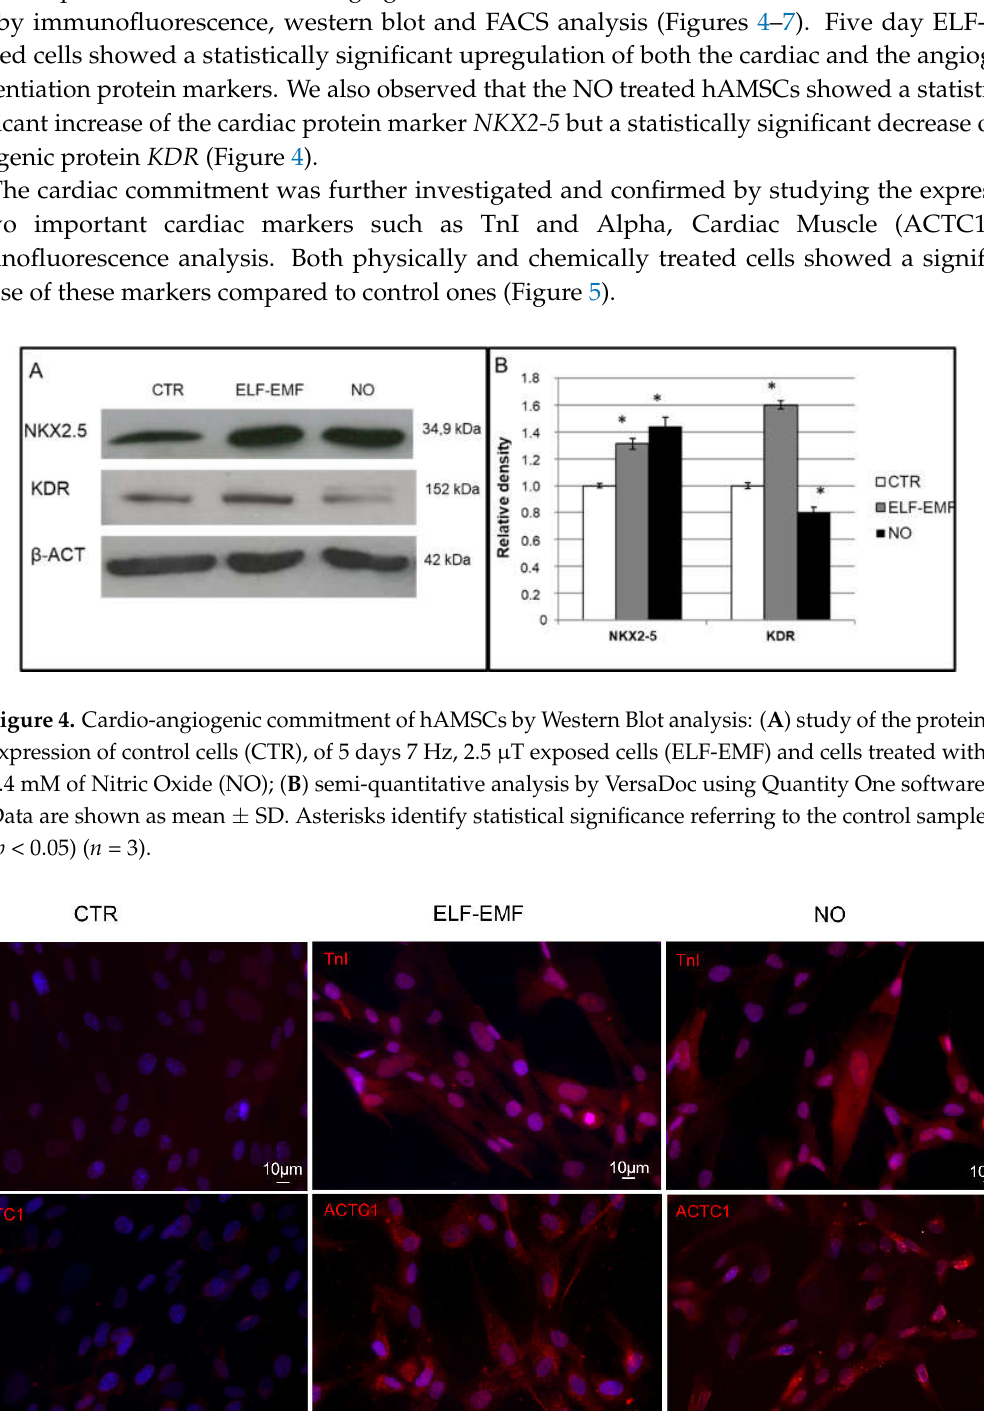
Figure 6. hAMSC protein expression by double indirect immunofluorescence analysis of NKX2‐5 (red) and VEGF (green): control cells (CTR), 5 days 7 Hz, 2.5 μT exposed cells (ELF‐EMF) and cells treated with 0.4 mM of Nitric Oxide (NO). Nuclei are counterstained with Hoechst (blue) ( n = 3).